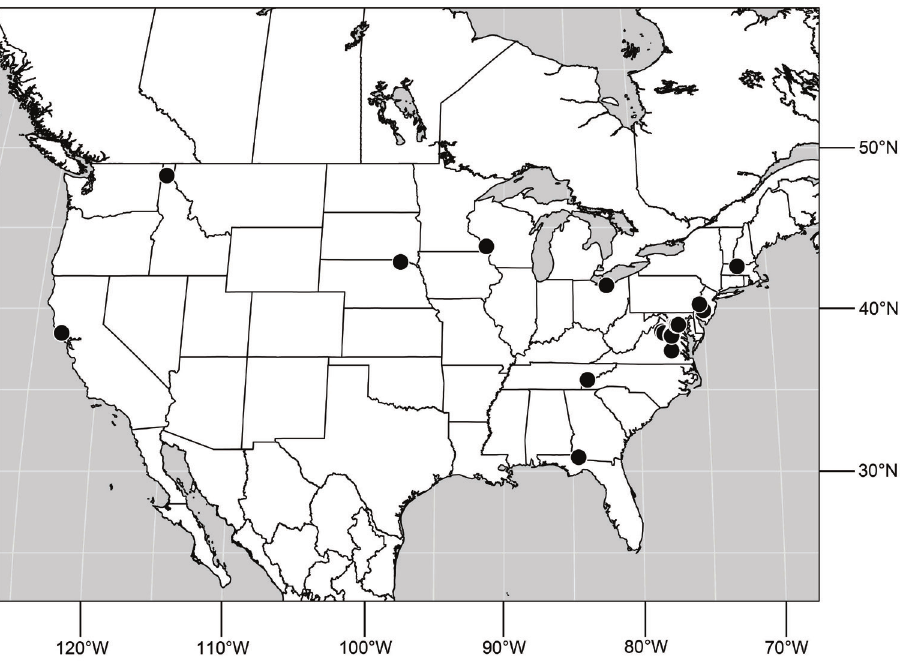
Figure 171. Distribution of Hydrochasma garvinorum Mathis and Zatwarnicki